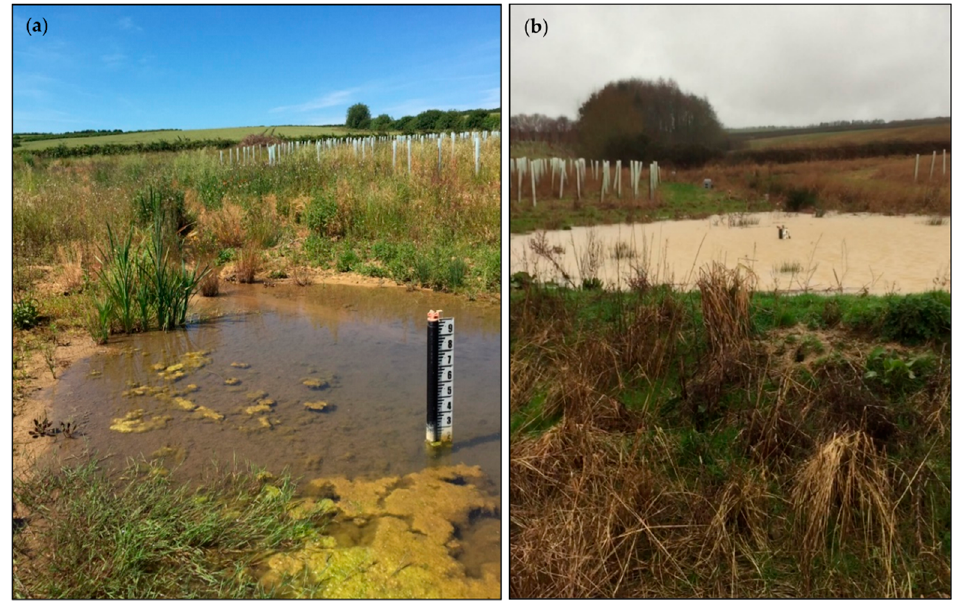
Figure 2. The Central Pond during ( a ) low flow conditions in July 2019; and ( b ) at capacity during a storm event on 15 February 2020. Both photos are taken facing upstream.